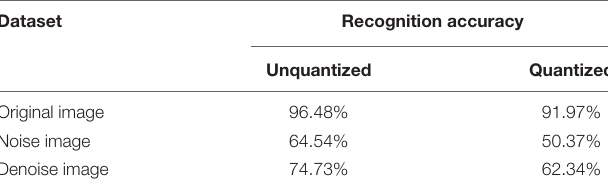
TABLE 1 | The results of three samples were tested on unquantized and quantized